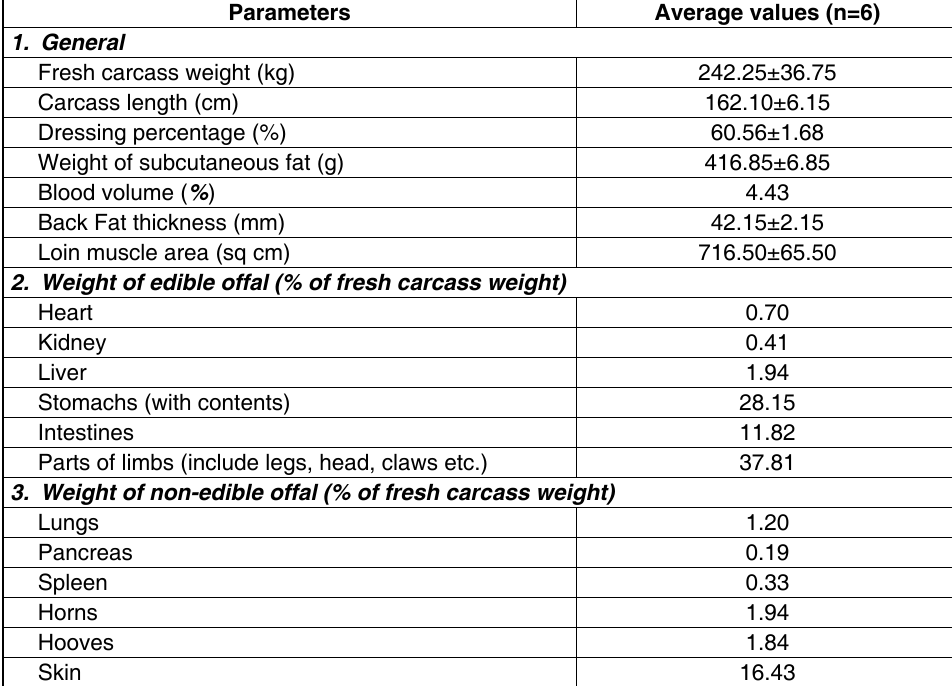
table 1. Physical characteristics of mithun carcass Parameters